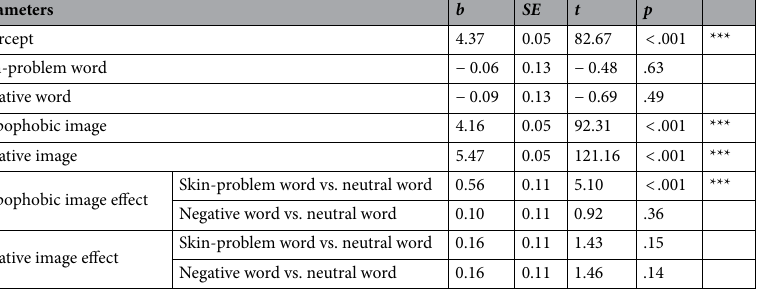
Table 1. Model-based estimates and relative importance values of each parameter. SE standard error of the estimate, Trypophobic image effect trypophobic image vs. neutral image, Negative image effect negative image vs. neutral image . *** p <